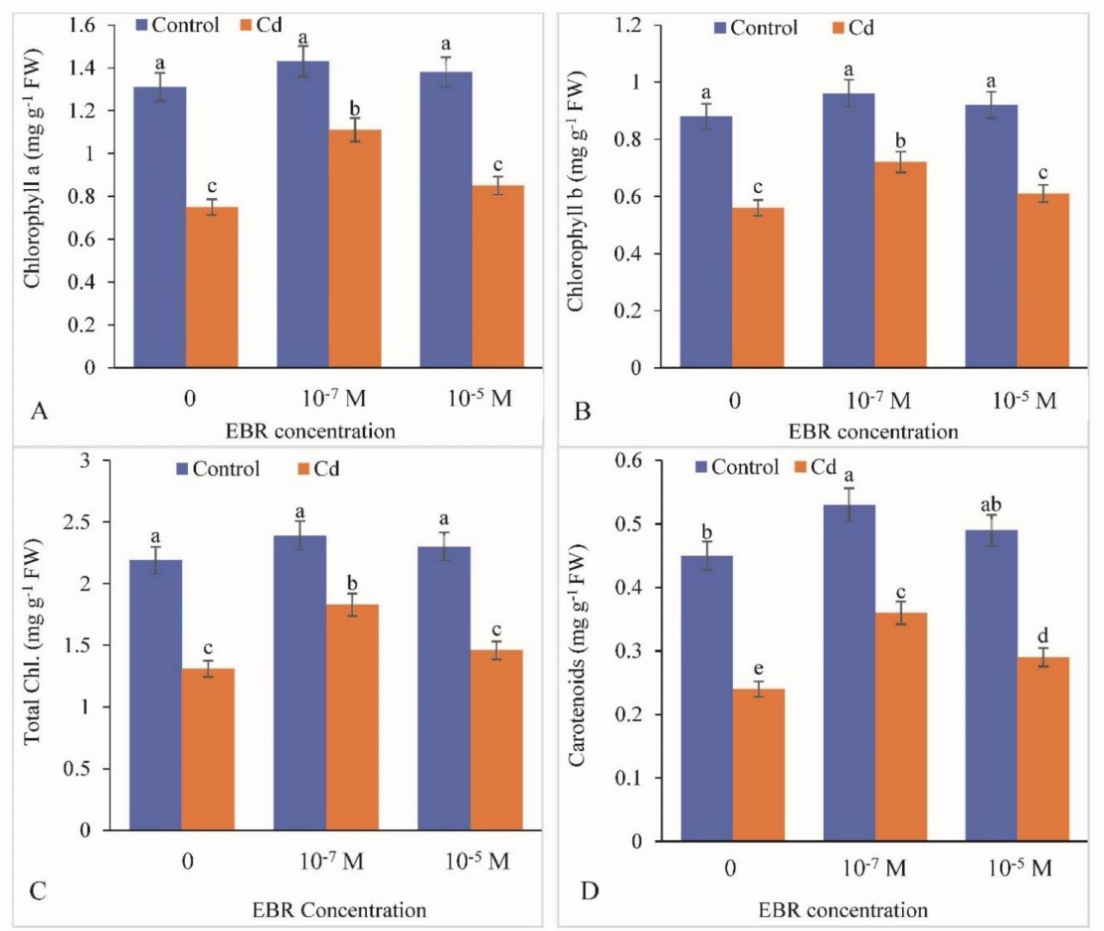
Figure 2. 24-Epibrassinolide restores the ( A ) chlorophyll a, ( B ) chlorophyll b, ( C ) total chlorophyll and ( D ) carotenoid content in the leaves of B. juncea under Cd (200 µ M) stress. Values with di ff erent letters above the bars are significantly di ff erent at each measured time point ( p < 0.05) (Mean ± S.E.). 2.3. Variation in Photosynthetic Parameters (Chlorophyll Fluorescence) Net photosynthesis rate and transpiration rate decreased by 61.37% and 58.80%, respectively; however, stomatal conductance increased by 46.34% in Cd stress plants compared with the controls (Figure 3A–C). A linear elevation in net photosynthetic rate, stomatal conductance and transpiration rate were recorded with increase in 24-EBR supply (Figure 3). The net photosynthesis rose by 51.20% − 7 − 5 and 17.54% in 10 and 10 M 24-EBR, respectively, compared with the controls. The enhancement in stomatal conductance (23.33% and 15%) and transpiration rate (91.70% and 40.66%) were observed − 7 − 5 in 10 and 10 M 24-EBR-supplemented plants, respectively, in comparison with the control plants (Figure